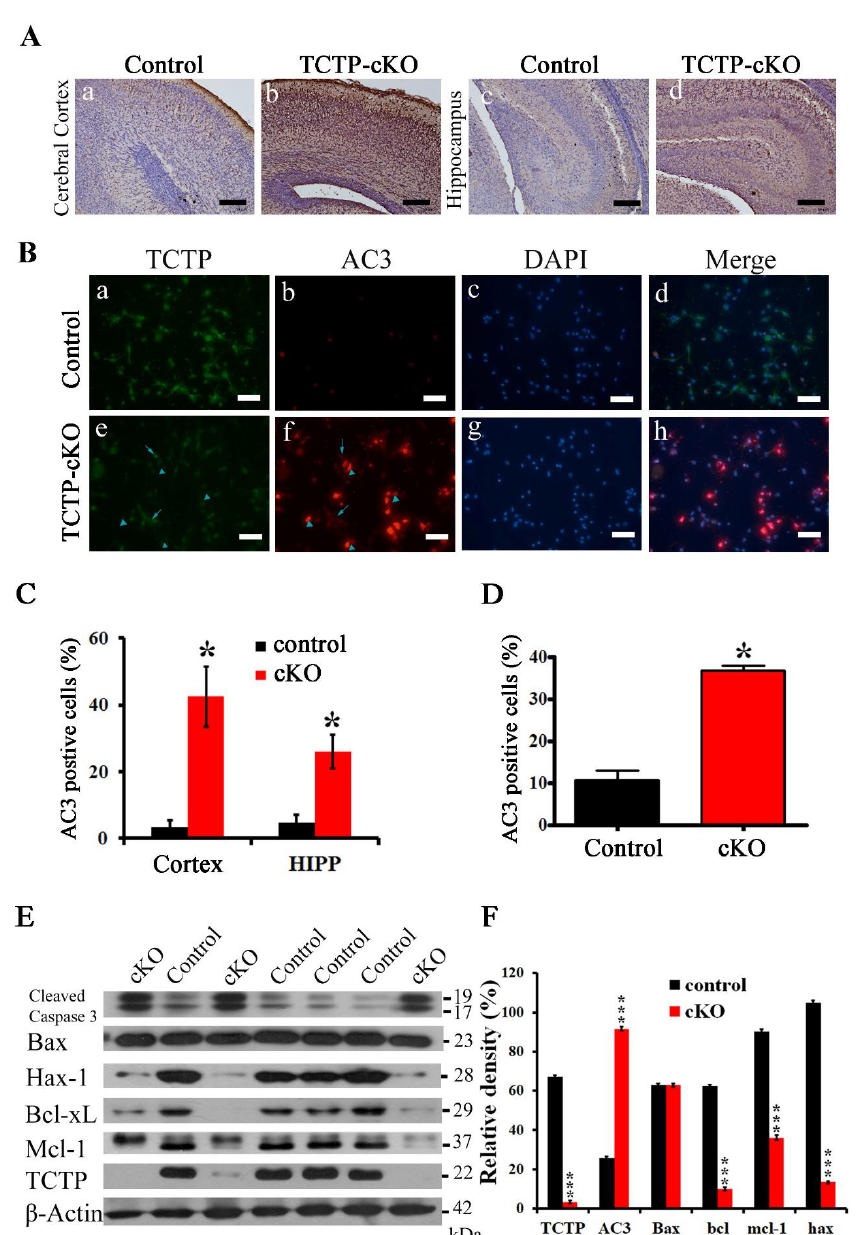
Figure 8. Caspase cleavage apoptosis was detected by immunohistochemistry, immunofluorescence, and Western blot. Apoptotic and antiapoptotic related protein levels were detected by Western blot. ( A ) Cerebral cortex and hippocampus of control and TCTP-cKO mice were stained for active caspase-3 (AC3) by immunohistochemistry at P0.5. ( B ) Double immunofluorescence staining for TCTP (green) and AC3 (red) of primary neuronal cell from control and TCTP-cKO mice at E16.5. The arrow indicates TCTP-positive cells, and the arrowhead indicates TCTP-negative cells. ( C ) Bar graph summarizing the quantification of active caspase-3 staining in ( A ). ( D ) Bar graph summarizing the quantification of active caspase-3 staining in ( B ). (Data presented as mean ± SEM, * p ≤ 0.05, Student’s t test, n = 3 per group). ( E ) Protein levels of cleaved caspase-3, bax, hax-1, bcl-xl, mcl-1, and TCTP in control and TCTP-cKO mice were measured by Western blotting at P0.5. ( F ) Bar graph summarizing quantification of Western blot in ( E ). Relative density is presented as the ratio of band intensity of target protein to the internal control, β -actin. (Data presented as mean ± SEM, *** p < 0.001, Student’s t test, n = 3 per group). Scale bars: A, 100 µ m; B, 40 µ